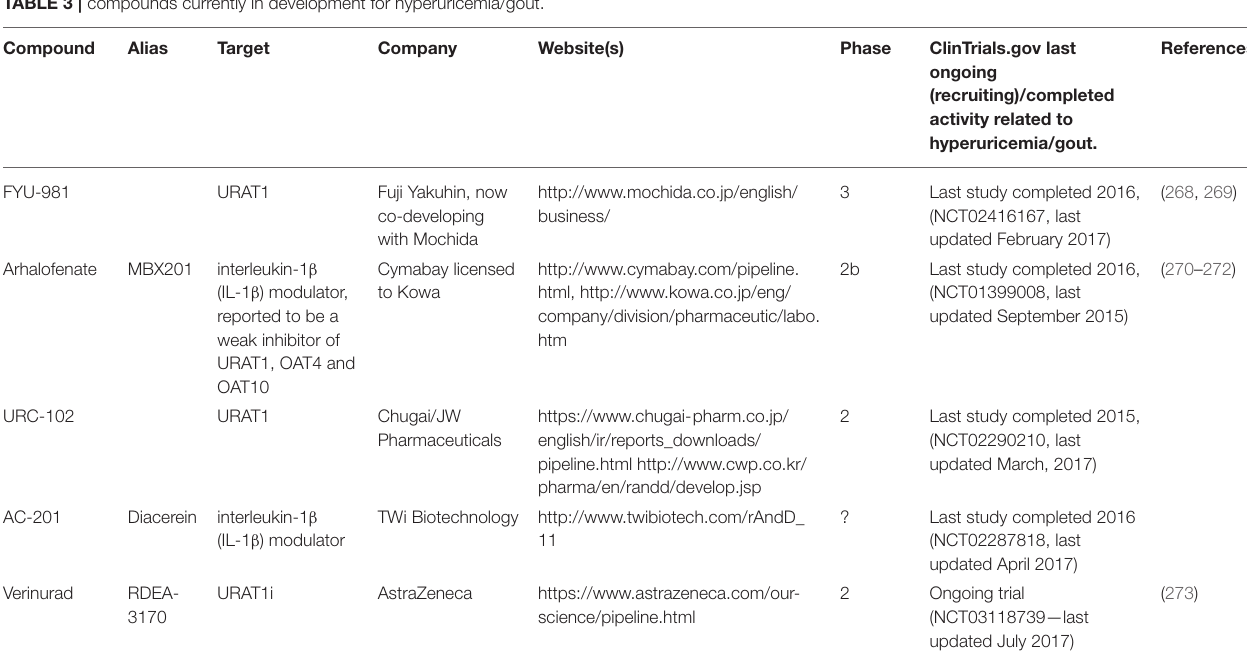
TABLE 3 | compounds currently in development for